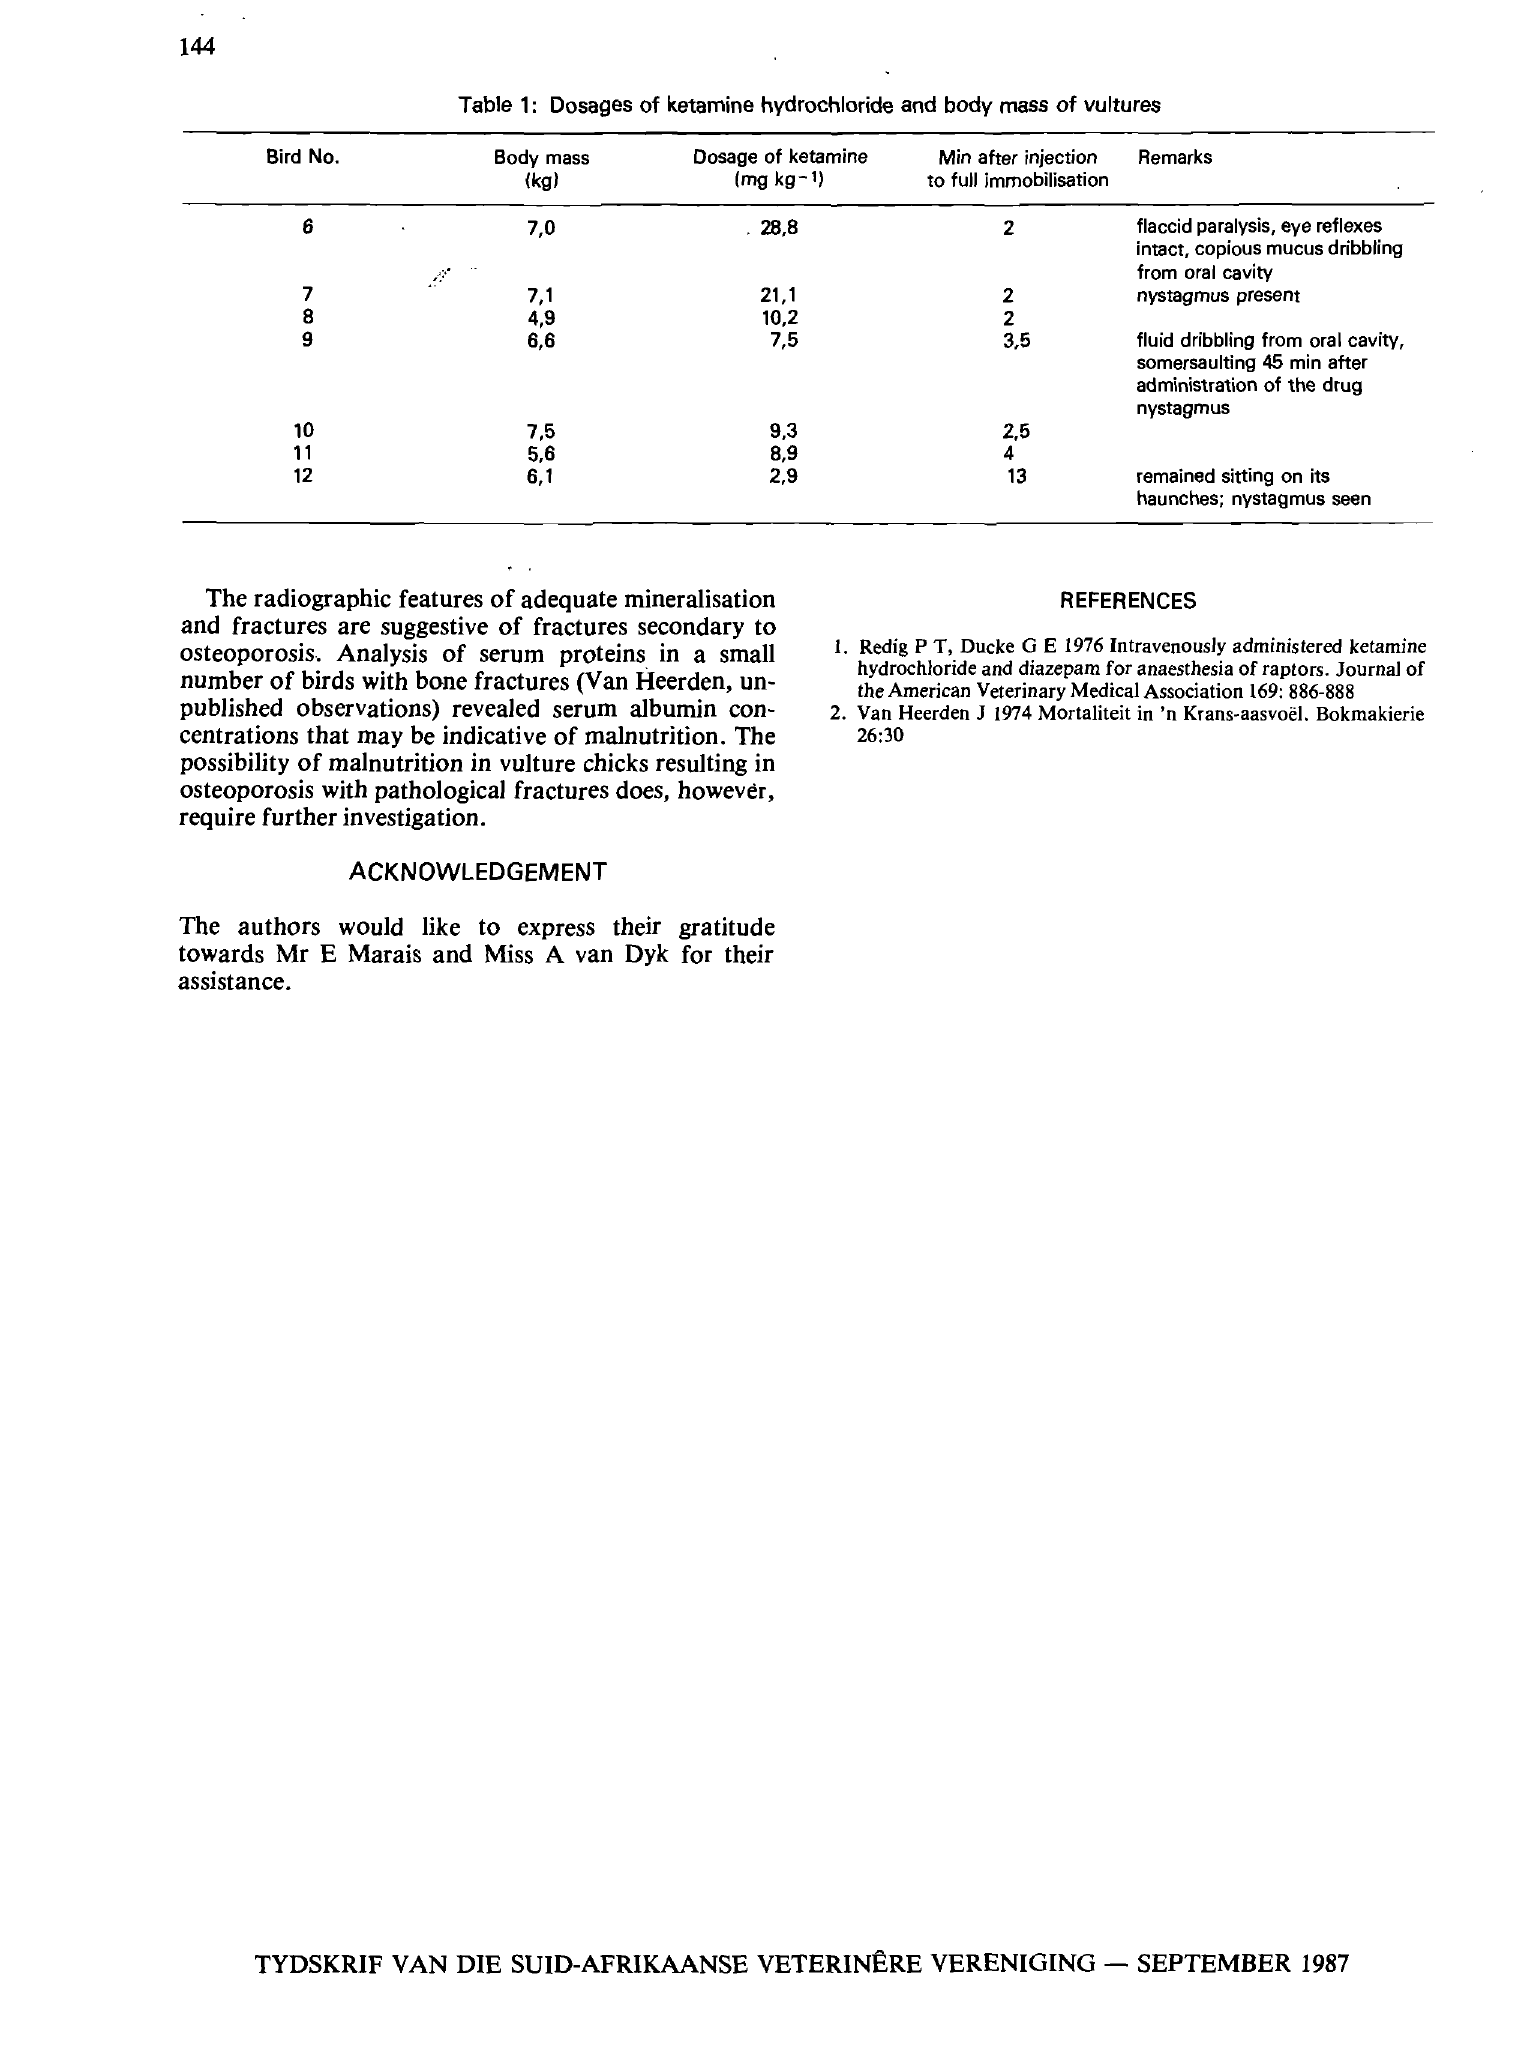
TYDSKRIF VAN DIE SUID-AFRlKAANSE VETERINERE VERENIGING - SEPTEMBER